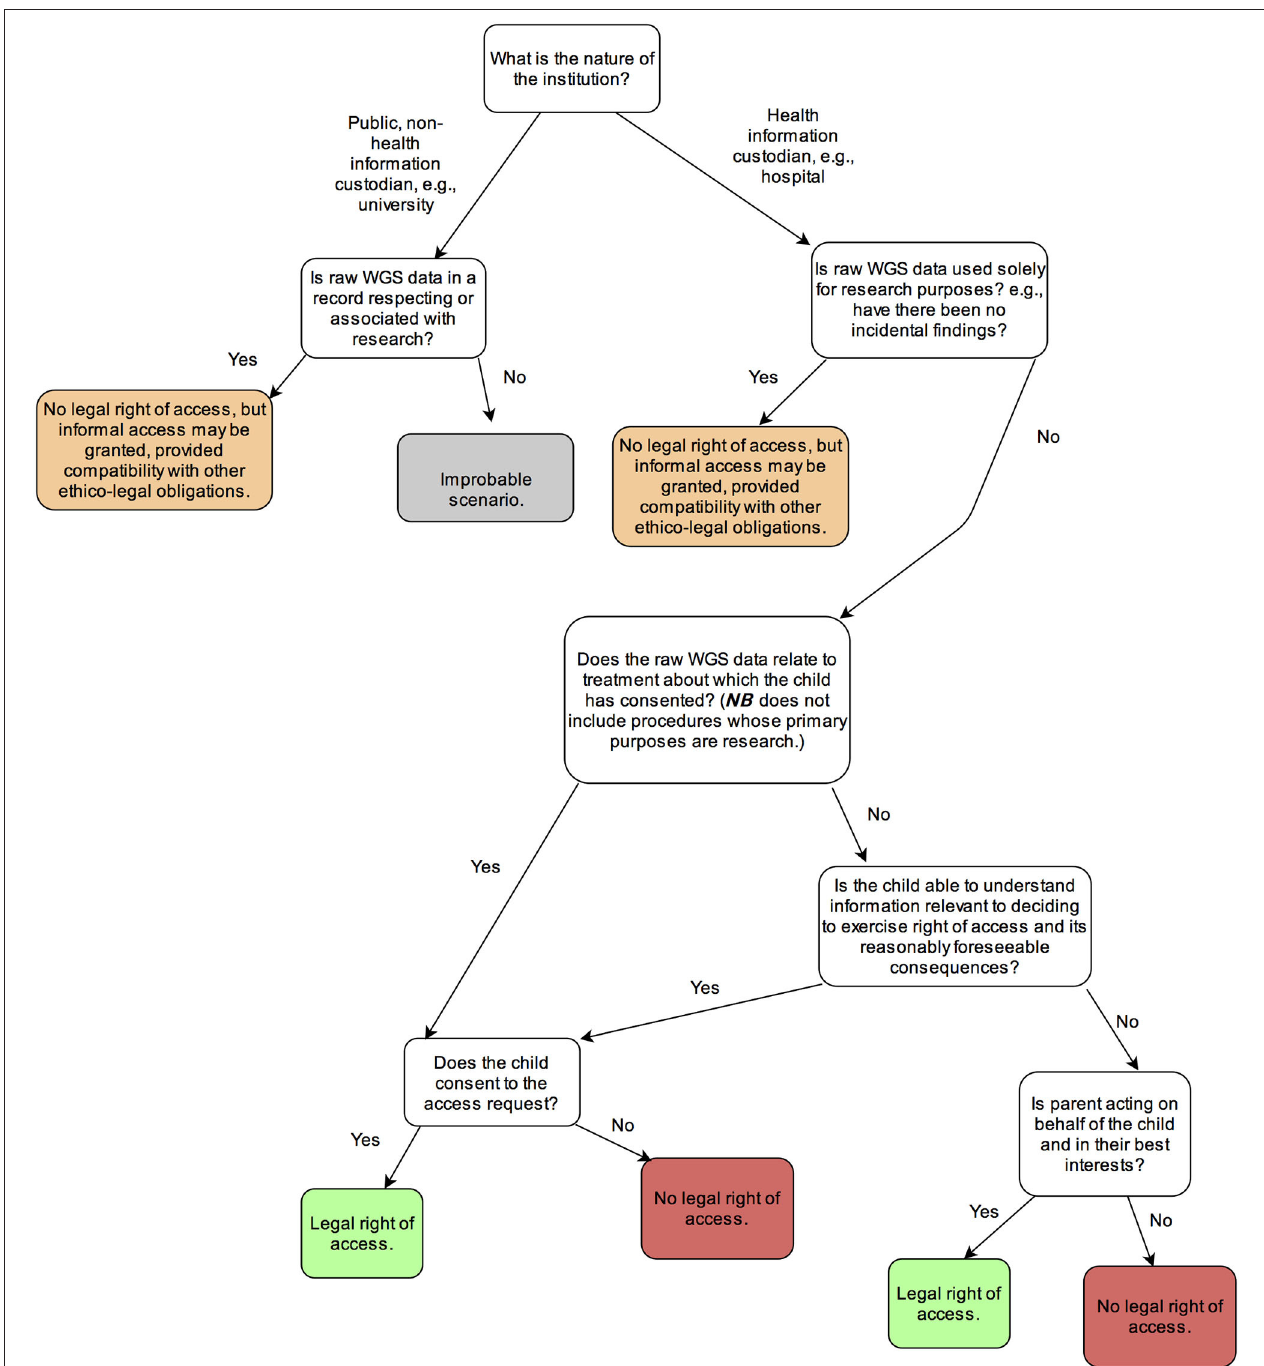
FIGURE 1 | Decisional tree for determining whether parents have a legal right of access to their child’s personal information in Ontario.